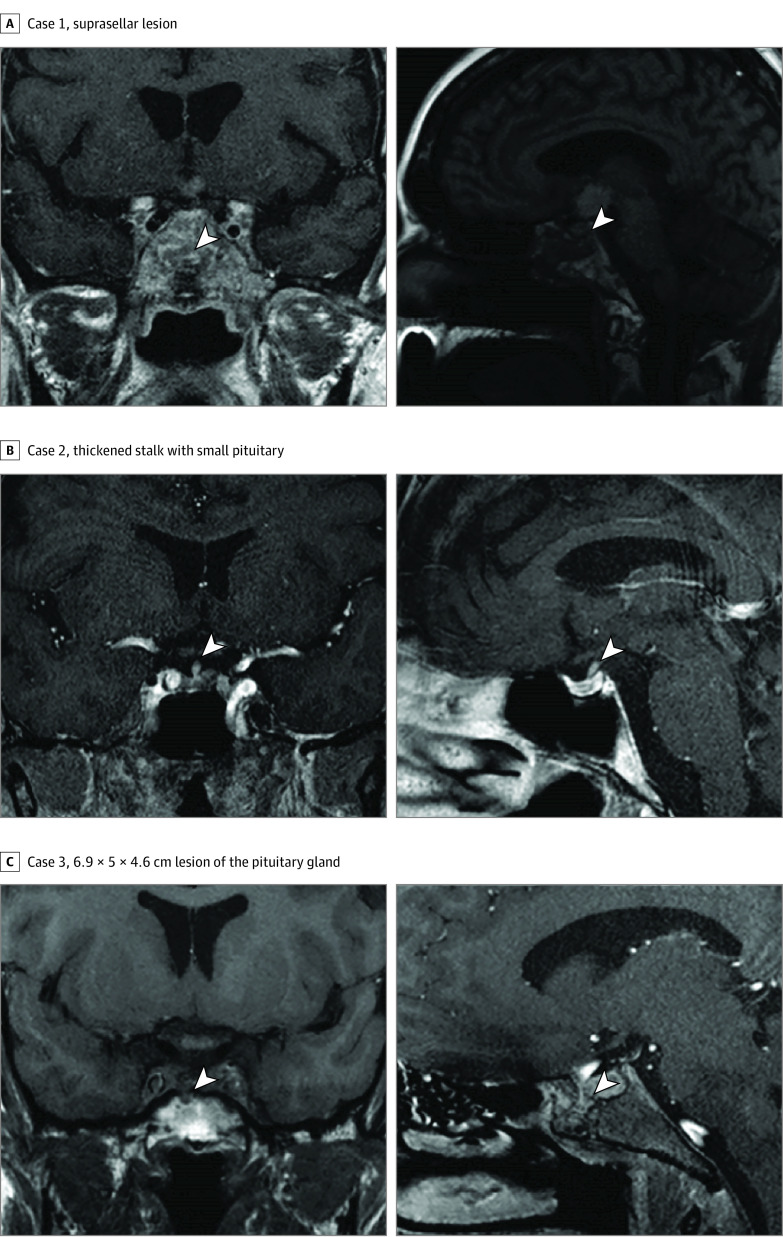
T1-Weighted Magnetic Resonance Imaging Scans of 3 Patients With Central Hypothyroidism